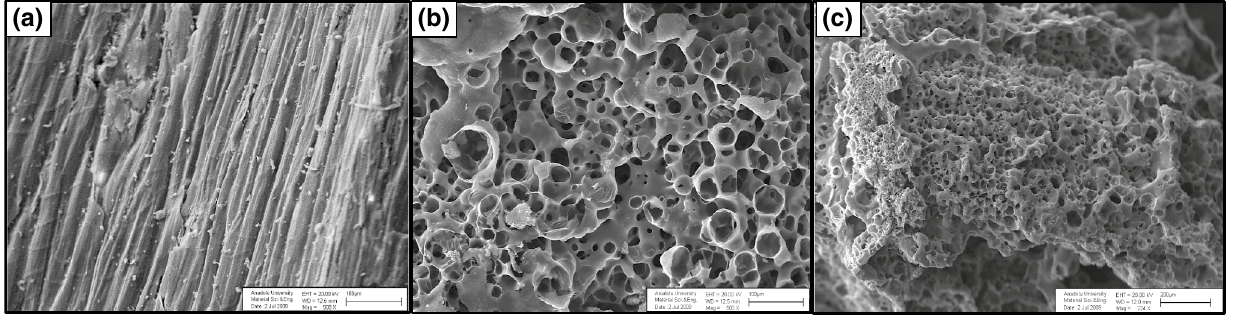
2 CO 3 activated